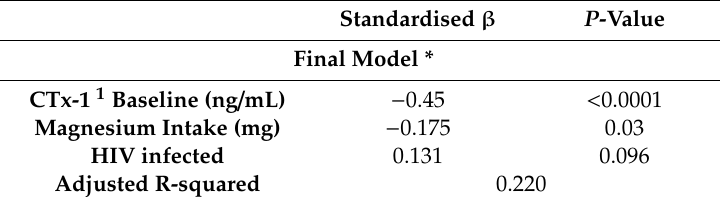
Table 4. Multiple regression analyses for percentage change in C-Telopeptide of type 1 collagen as dependent